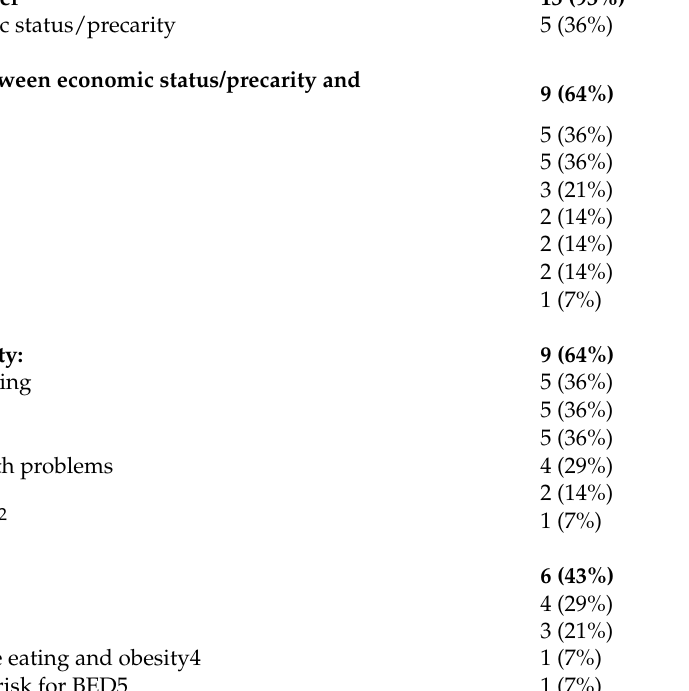
Table 6. Participant statements consistent with Theme 3, “economic, food, and nutrition scarcity and